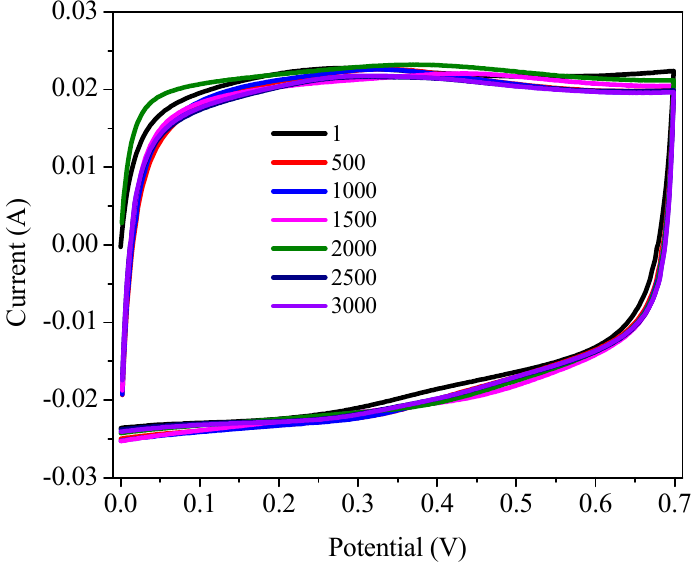
Figure 9. Cyclic voltammograms recorded for the device in potential range of 0–0.7 V at scan rate of 100 mV / 100 mV/s.